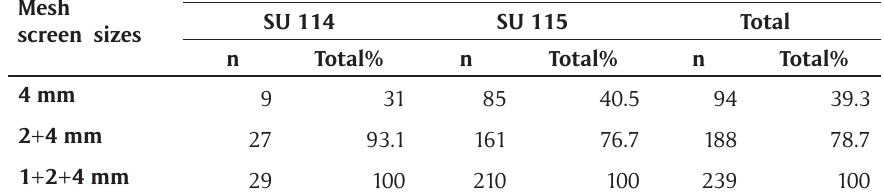
Table 4: Comparison of Minimum Number of Individuals (MNI) of the sea urchin Paracentrotus lividus obtained in units 114 and 115 using 4, 2 and 1 mm mesh